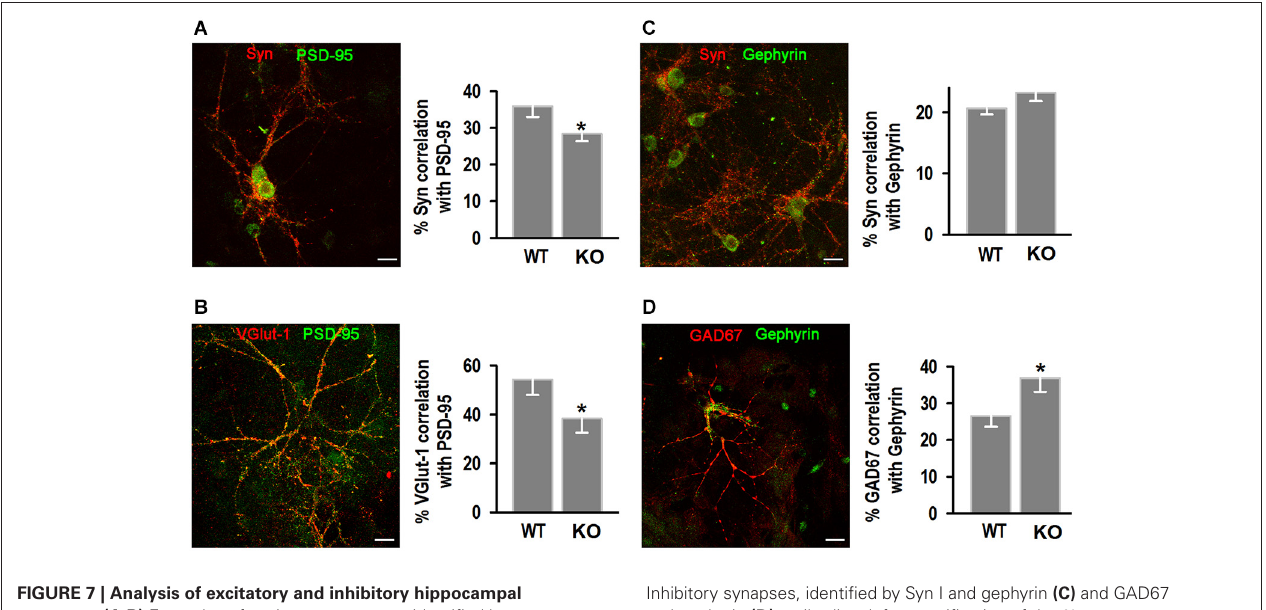
FIGURE 7 | Analysis of excitatory and inhibitory hippocampal synapses. (A,B) Examples of excitatory synapses, identified by synapsin I (Syn) and PSD-95 antibodies (A) and VGlut-1 and PSD95 antibodies (B) ; left, quantification of the % co-localization of Syn I with PSD95 ( n = 20, 20) or VGlut-1 with PSD95 ( n = 15, 14). (C,D)